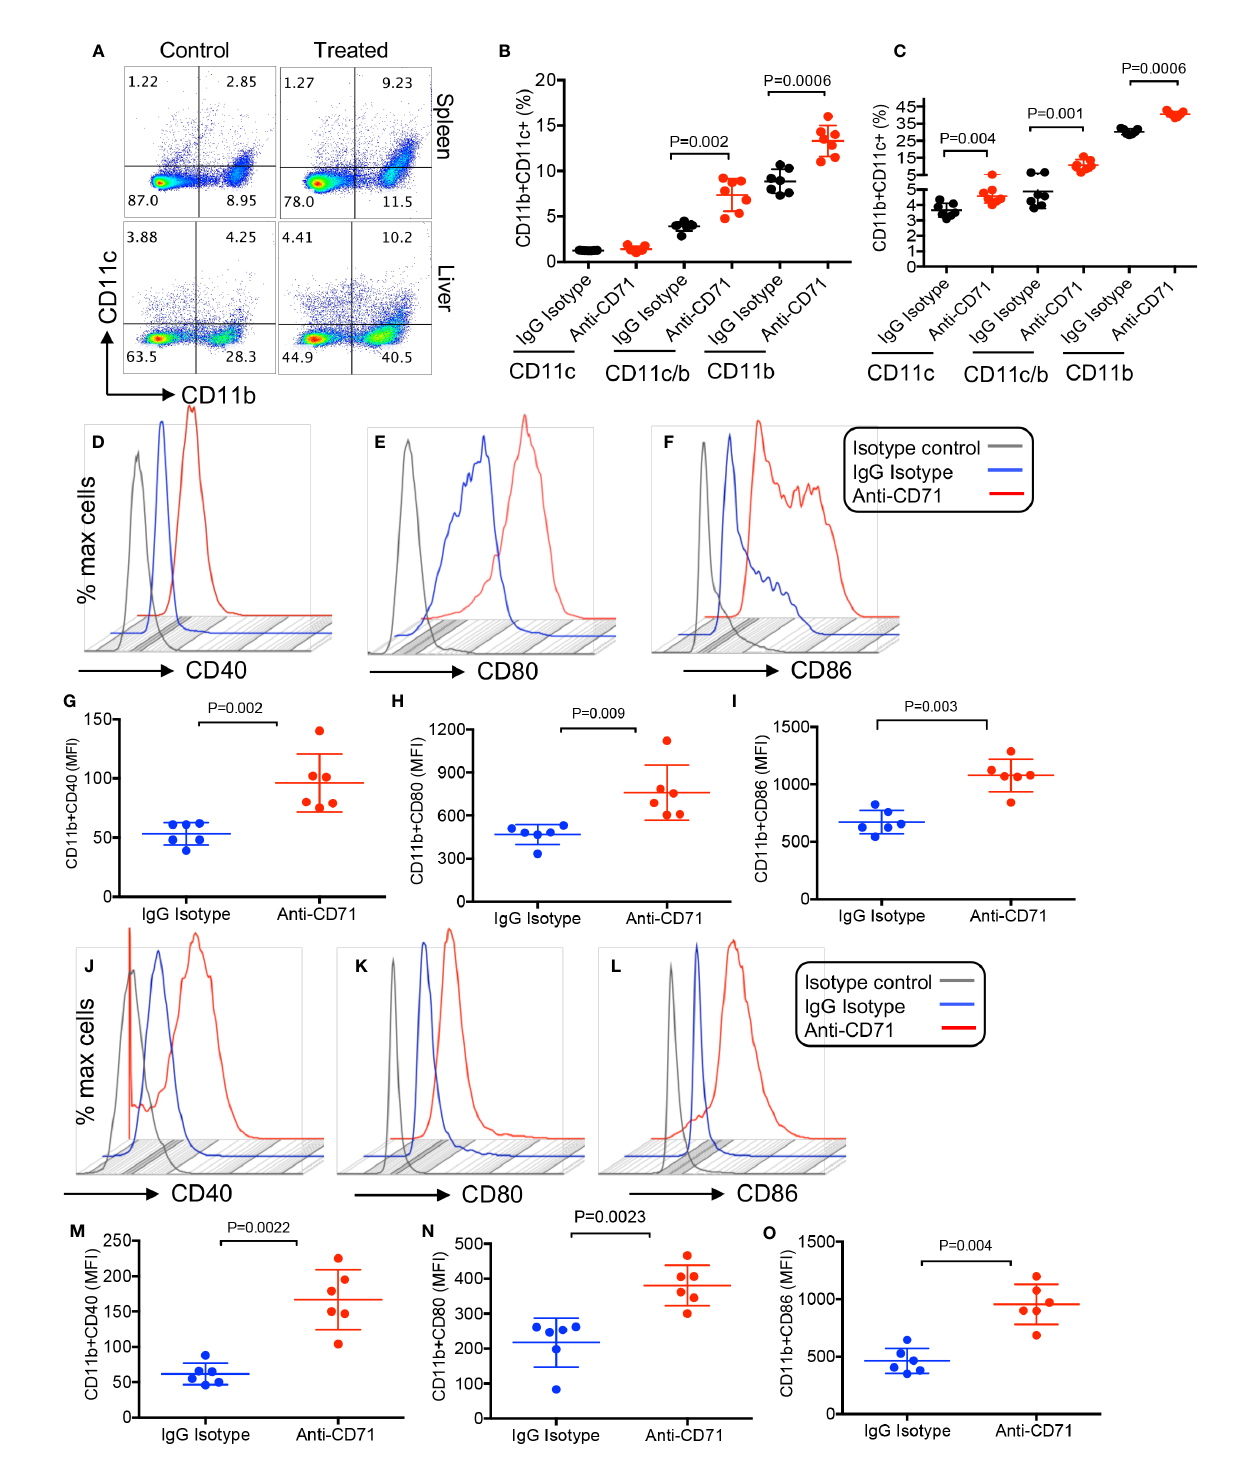
FIGURE 6 | Increase of effector immune cells 48 h post the depletion of CECs and 24 h after oral infection with Listeria monocytogenes. (A) Representative plots and (B) quanti fi cation of CD11b+, CD11c+, and CD11b+CD11c+ cells in the spleen and (C) the liver. (D – F) Representative plots, and (G – I) quanti fi cation of activation markers CD40, CD80, and CD86 in splenic CD11b+ by mean fl uorescence intensity (MFI). (J – L) Representative plots, and (M – O) quanti fi cation of activation markers CD40, CD80, and CD86 in hepatic CD11b+ by mean fl uorescence intensity (MFI). Differences in mean values analyzed by two-tailed Student ’ s t test; p value is shown; N ≥ 6/group, from at least two